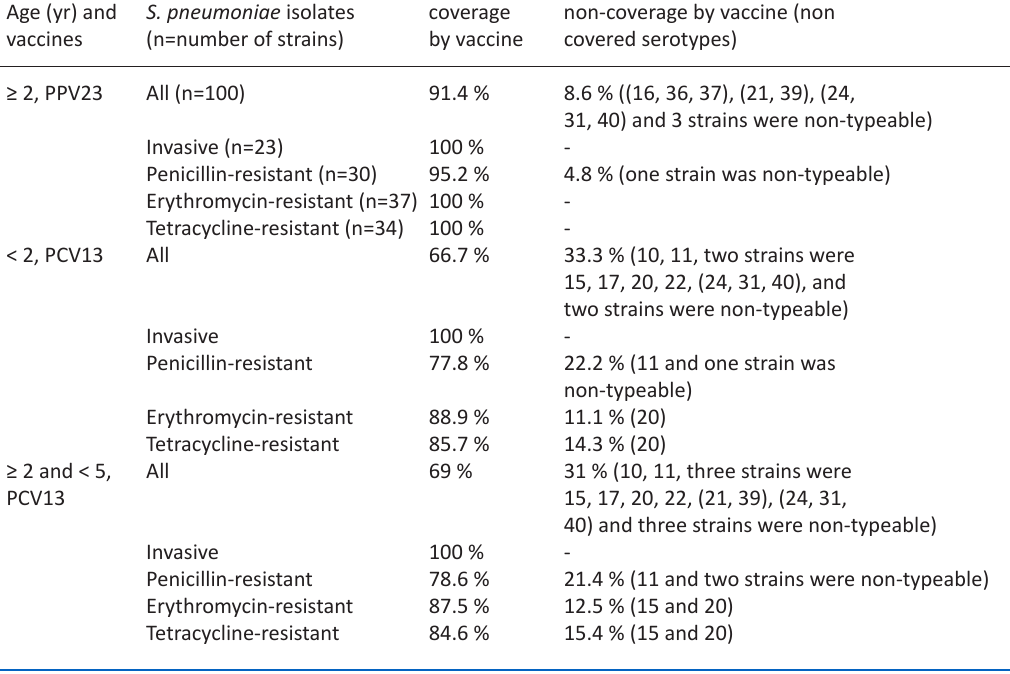
Table 5. S. pneumoniae serotypes identified in children and their coverage by pneumococcal vaccines Age (yr) and S. pneumoniae